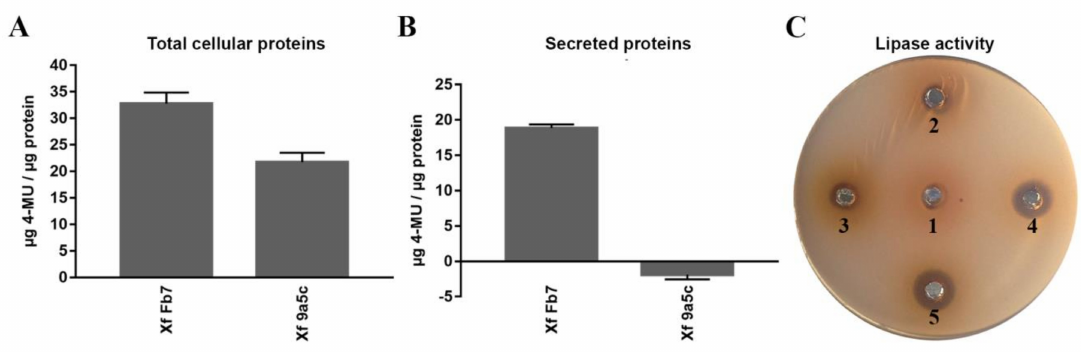
Figure 6. Esterase and lipase activities of X. fastidiosa strains Fb7 and 9a5c protein extracts. Esterase activity of ( A ) total cellular and ( B ) secreted proteins. ( C ) Lipase activity of the proteins secreted from X. fastidiosa strain 9a5c at 6 and 10 days of culture (2 and 3) and X. fastidiosa strain Fb7 at 6 and 10 days of culture (4 and 5). The PW culture medium was used as a negative control (1).